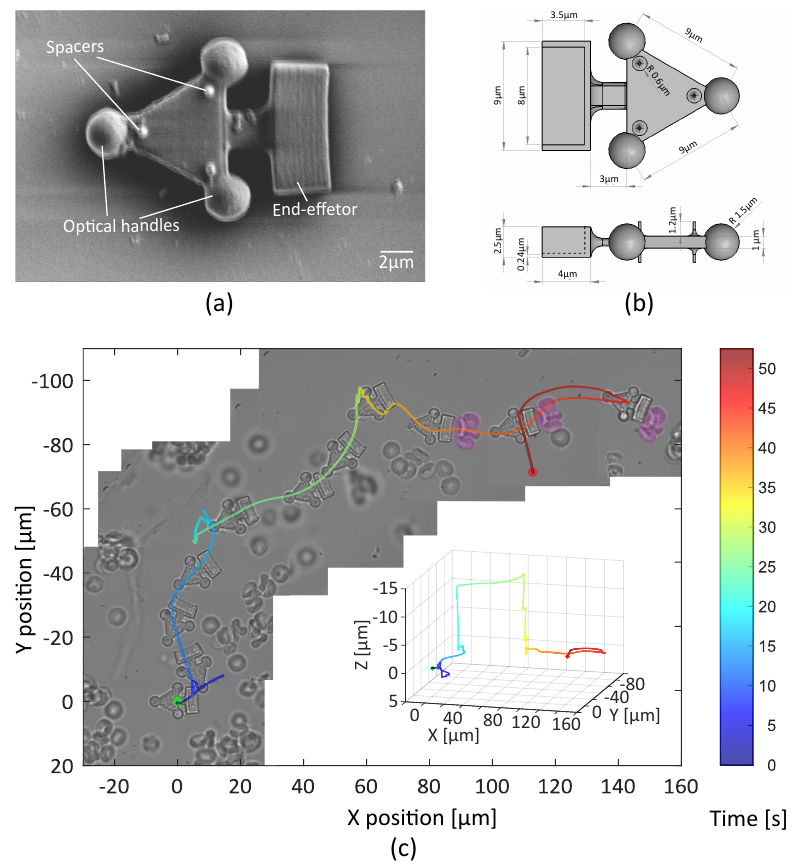
Figure 8. Robot with a shovel-shaped end-effector for cell transport. ( a ) Scanning electron microscopy (SEM) image of the robot. ( b ) Schematic depictions with dimensions of the robot. ( c ) 2D trajectory of the teleoperated robot with an inset of the 3D trajectory. Note that frames between T: 20 s and T: 30 s show the erythrocytes out-of-focus as the robot is elevated in the Z-direction. Then, a cluster of cells (colored in violet) is transported for 80 µm. Results also shown in Supplemental Video